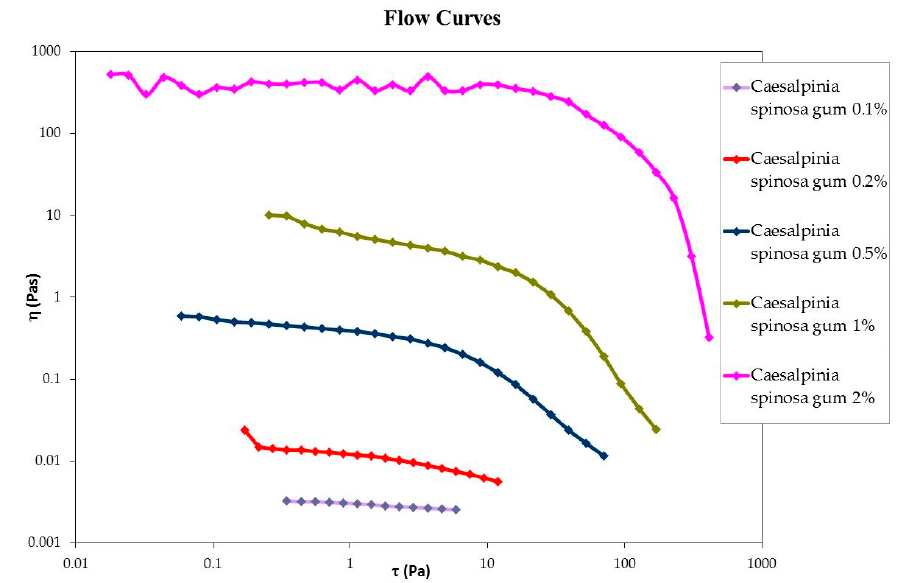
Figure 3. Flow curves of Caesalpinia spinosa gum at several concentrations (0.1%, 0.2% 0.5%, 1%, 2%) (Cone and plate rheometer, at 25 °C).